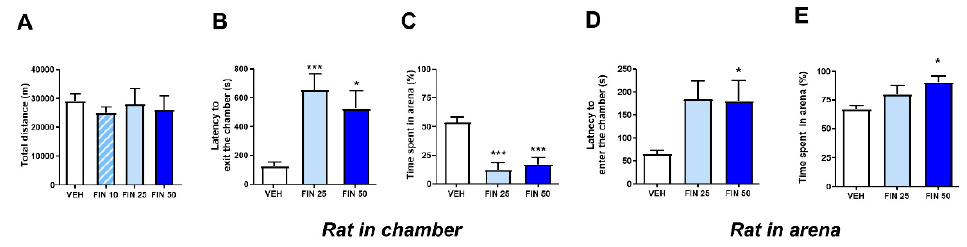
Figure 1. Finasteride (FIN) reduced exploratory drive in the defensive withdrawal paradigm. FIN did not a ff ect locomotor activity in rats tested in an actometer under total darkness; n = 6–7 / group ( A ). In the defensive withdrawal paradigm, FIN increased the latency to exit from a protected chamber and enter a brightly lit open arena ( B ), as well as the percentage of time spent in the arena itself, n = 12 / group ( C ). However, when animals were first placed in the open arena, FIN increased the latency to enter the protected chamber ( D ) and prolonged the percentage of time spent in the open arena n = 8 / group ( E ). * p < 0.05, *** p < 0.001 in comparison with rats treated with vehicle (VEH). Doses of finasteride are indicated in mg / kg